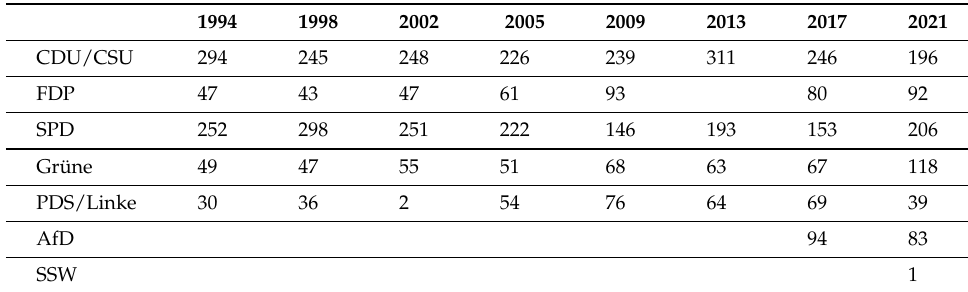
Table 9. German federal parliament,